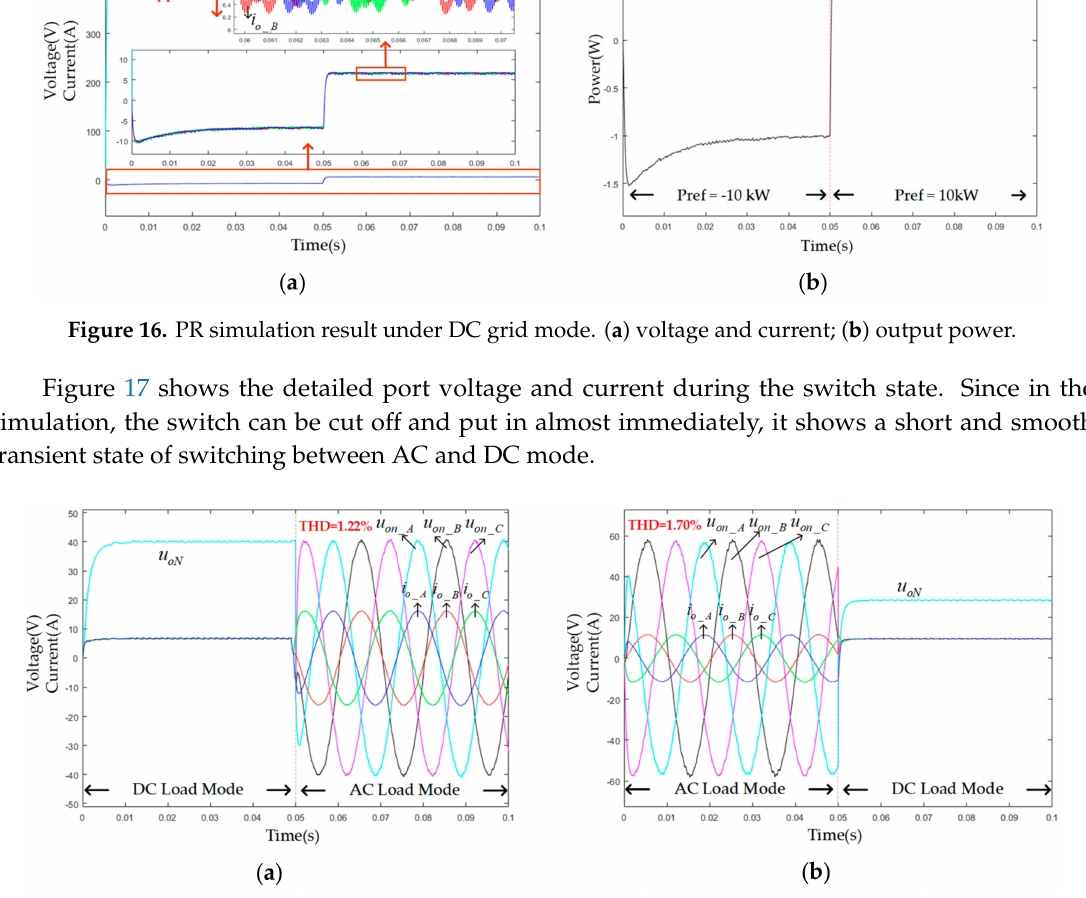
Figure 17. PR simulation result of switch state port voltage and current. ( a ) from DC Load Mode to AC Load Mode; ( b ) from AC Load Mode to DC Load